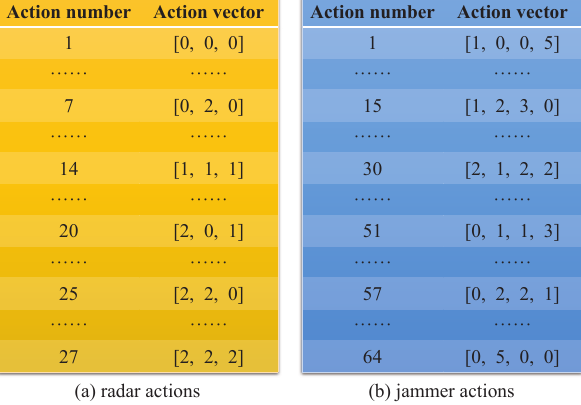
Figure 3. The relationship between action number and action vector for the radar and the jammer.